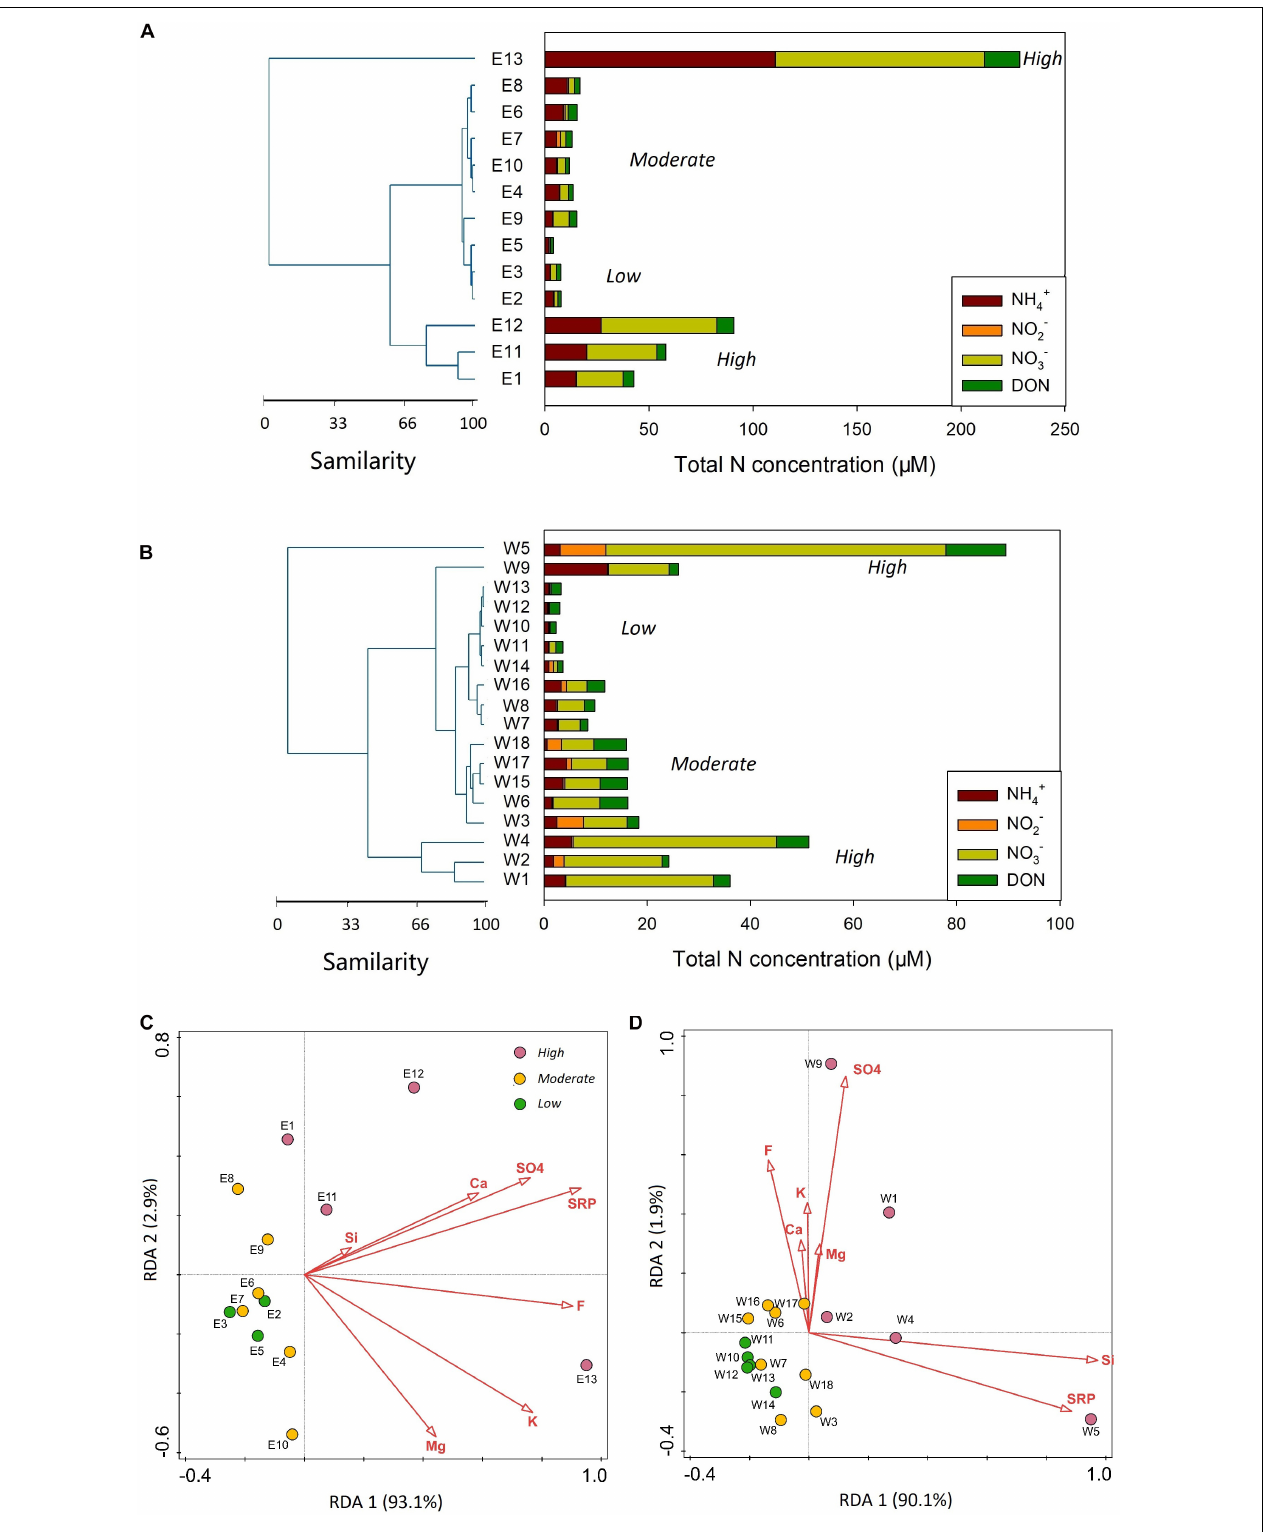
FIGURE 4 | (A,B) Cluster analyses for rainwater samples from both EIO and WPO based on concentrations of different N species. In both cluster analyses, three clusters are identified, namely, the low N, moderate N, and high N groups. (C,D) RDA results for the EIO and WPO rainwater samples, highlighting the difference among the low, moderate, and high N